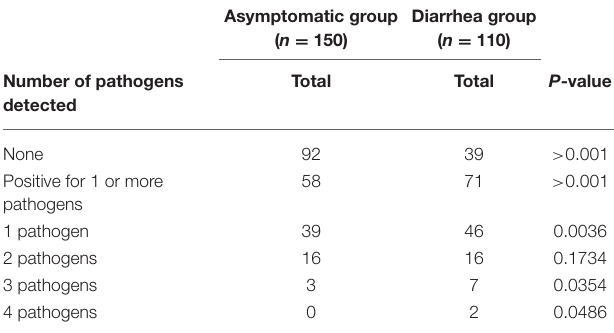
TABLE 2 | Association of enteric pathogens in fecal samples from children with and without diarrhea determined by virulence genes presence. Asymptomatic group ( n =